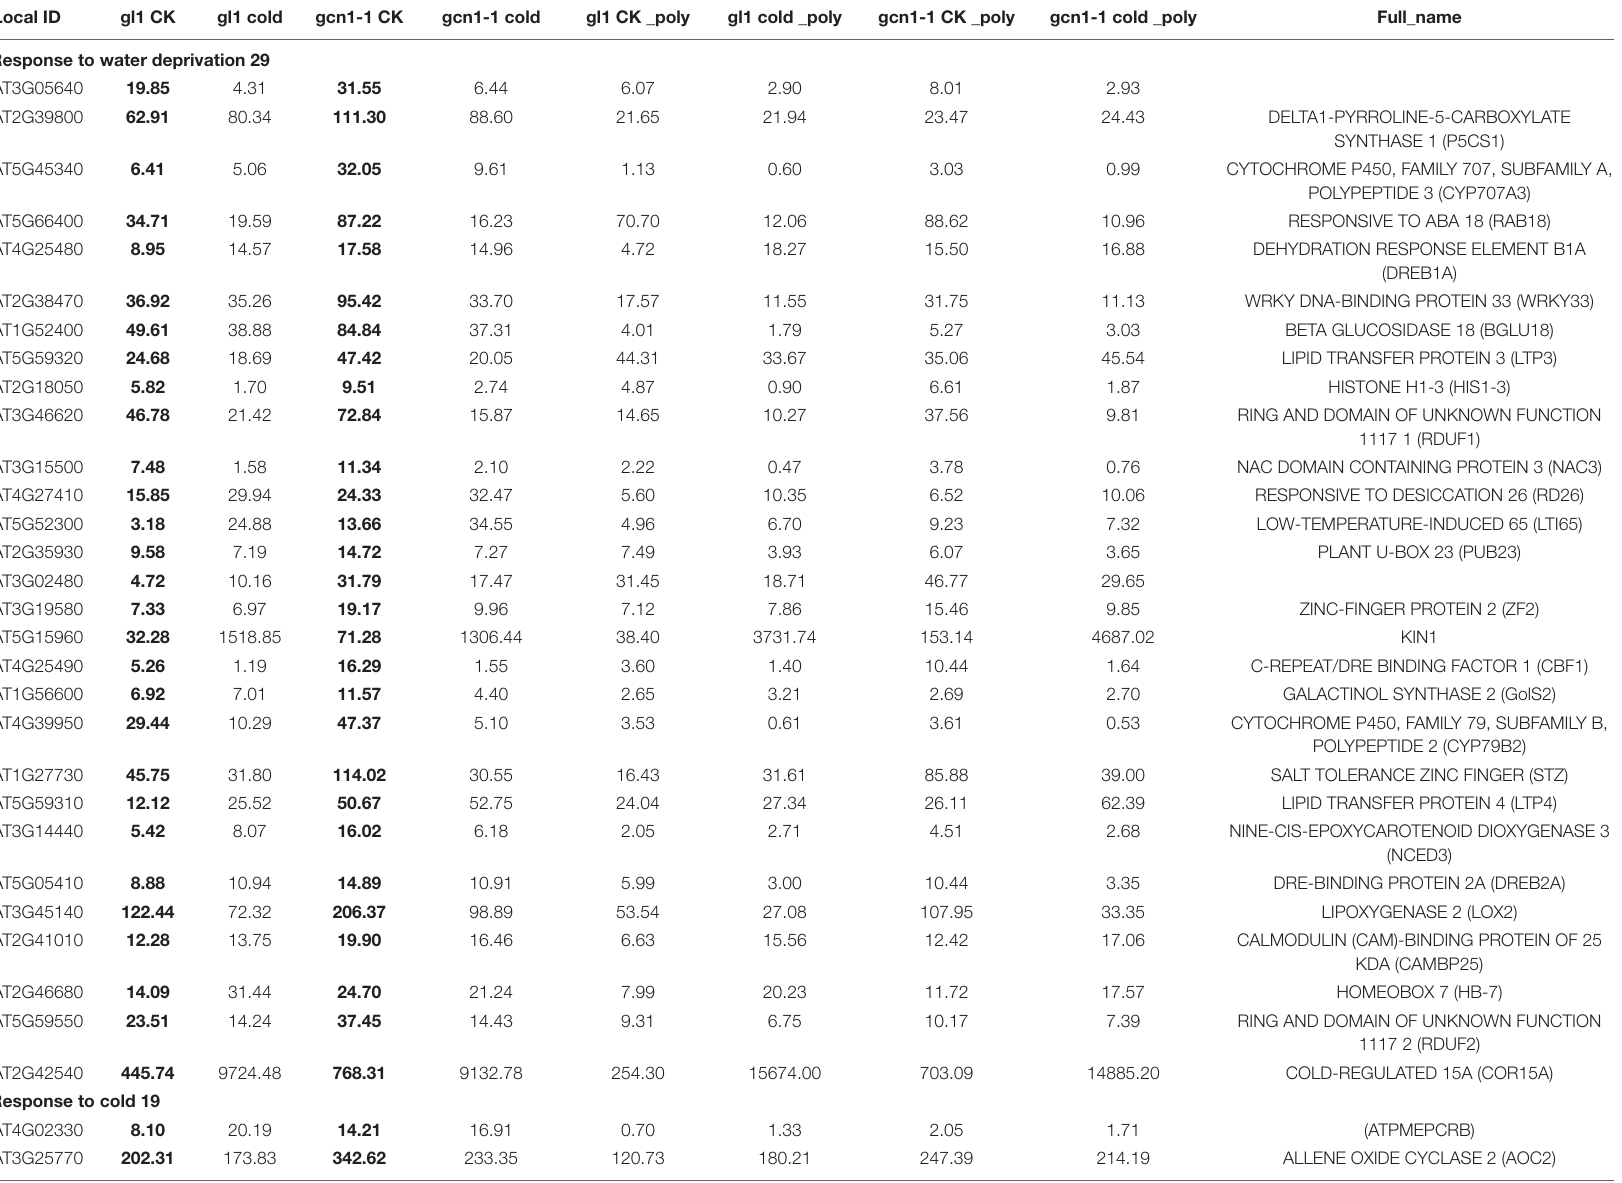
TABLE 7 | Partial classification data of up-transcribed genes in atgcn1-1 , compared with that in WT under normal temperature conditions. Local